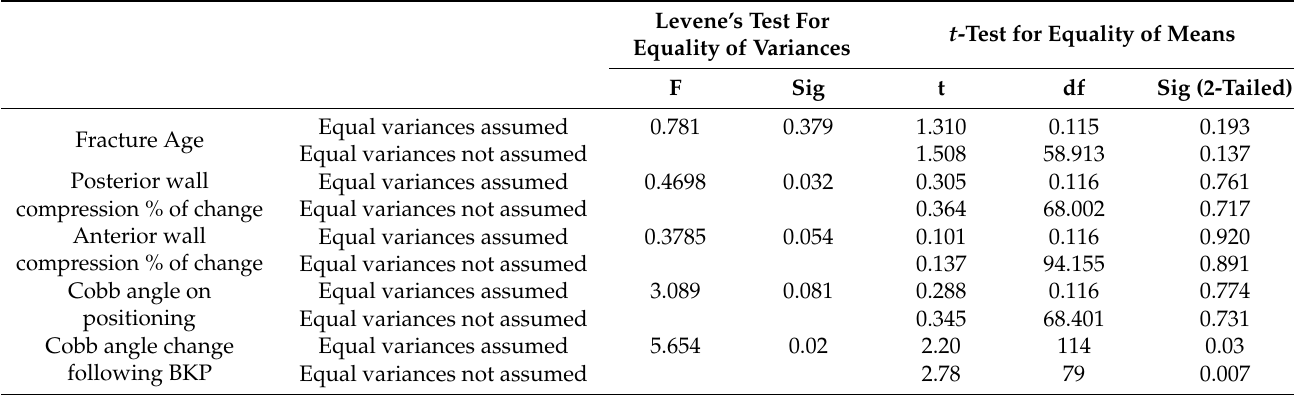
Table 2. Radiographic differences in UKP versus